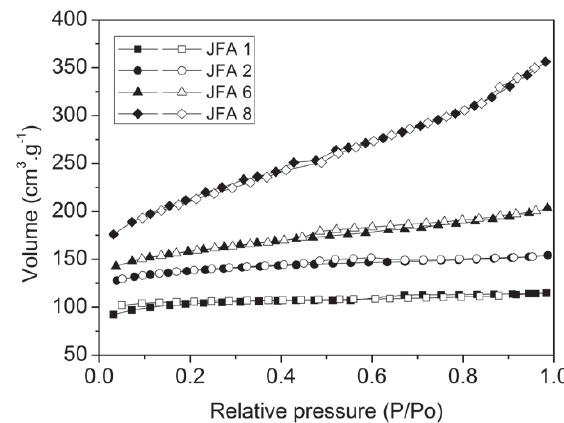
Fig. 4 - Adsorption (open symbols) and desorption (closed symbols) isotherms of N